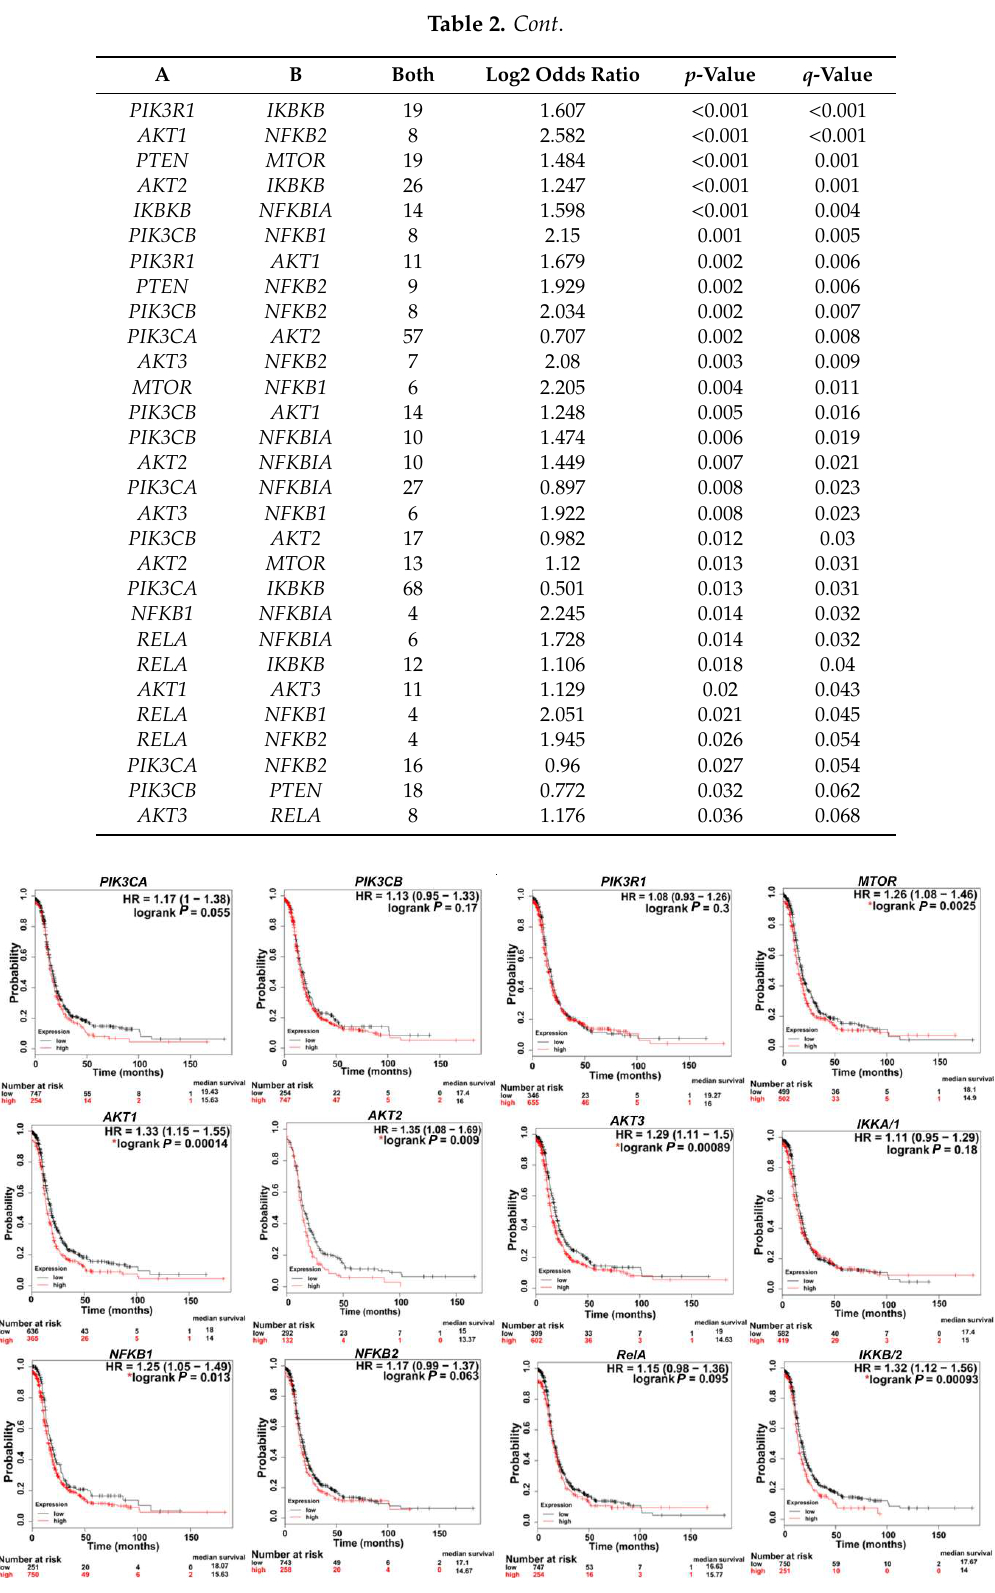
Figure 3. Kaplan–Meier (KM) plots indicating the correlation of PI3K/AKT/mTOR/NFκB expression with patient survival. * p < 0.05. KM curves were generated via a KM plot using only JetSet best probe set with analysis restricted to: Serous and Stages 3 + 4. Table 2. Summary of the tendencies of PI3K/AKT/MTOR/NFκB mutations to co-occur in OvCa (curated from http://www.cbioportal.org).